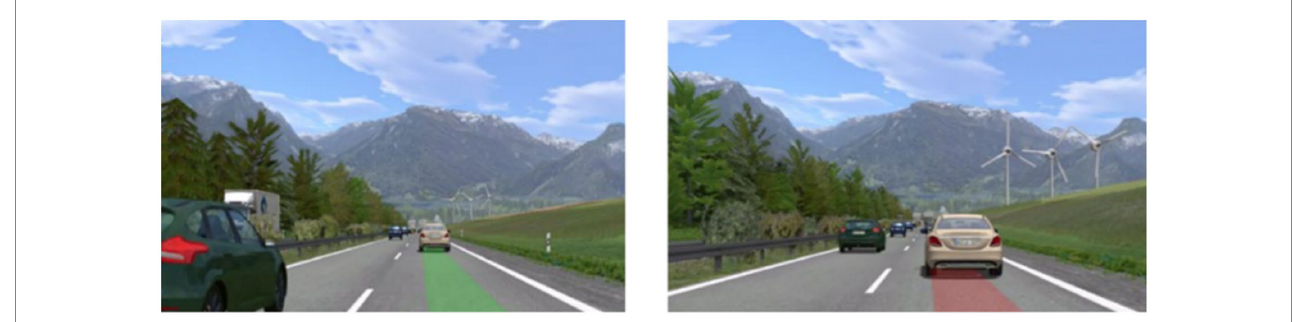
FIGURE 5 Shared safety distance head-up display. Left: Head-up display when the safety distance is sufficient. Right: Head-up display when the distance is below the safety threshold.